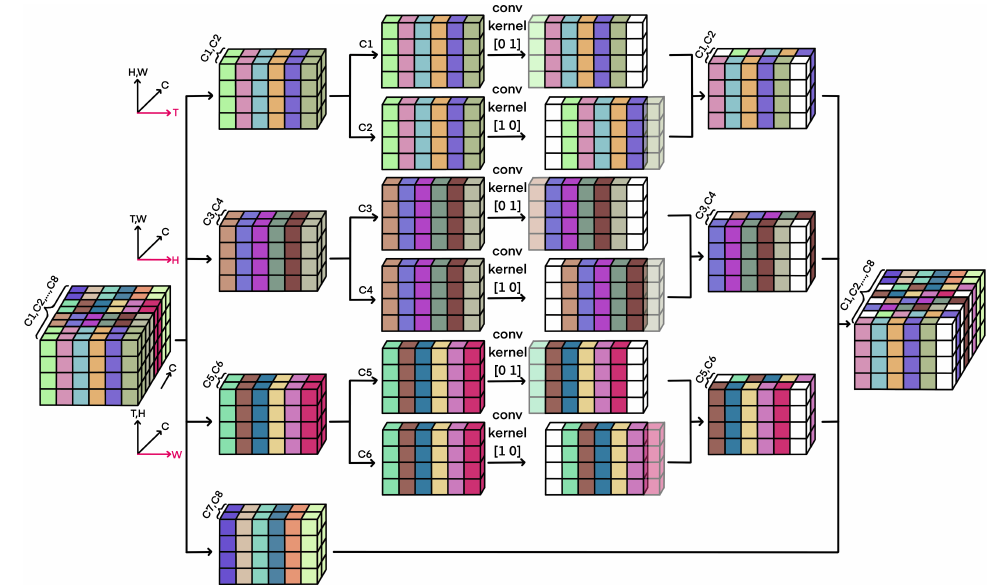
Figure 4. Revisiting of the 1D spatio-temporal shift operation from the perspective of matrix algebra. The figure shows the convolution calculation with a specific sparse convolution kernel and specific padding corresponding to the 1D spatio-temporal shift operation of Figure 3. The 1D spatio-temporal shift operation (T+H+W) is equivalent to the sparse convolution operation under specific padding. At this time, the sparse convolution kernel has only one non-zero component with a value of